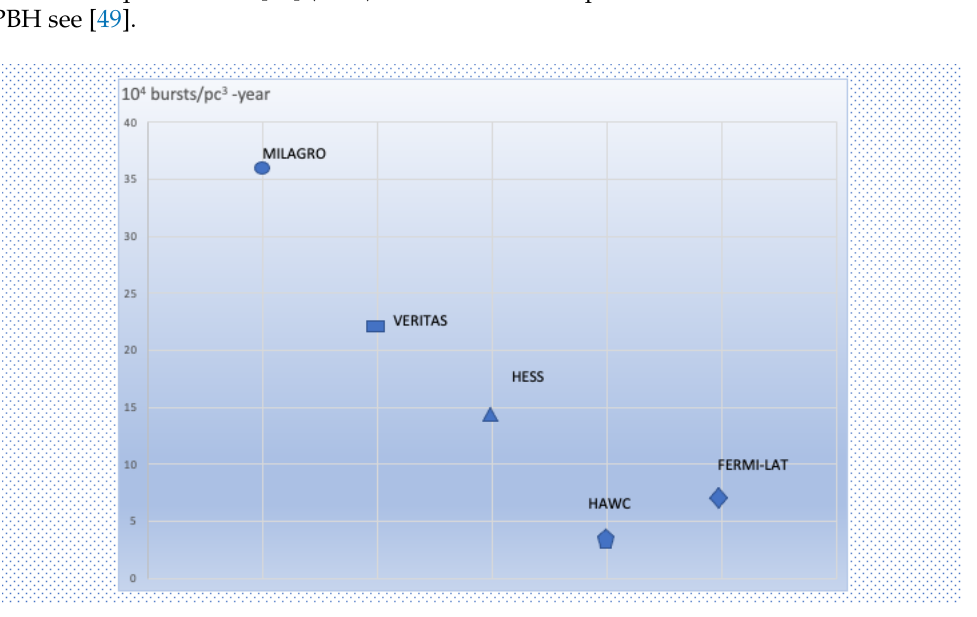
Figure 2. The upper estimates of the number of final bursts at the 99% confidence limit from some experiments